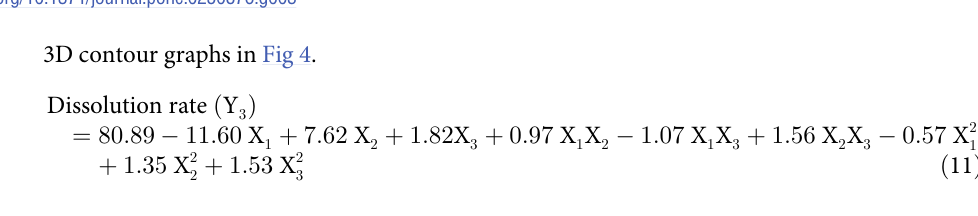
Fig 3. Drug release profiles of the microspheres prepared with (A) 50 mg of ethyl cellulose, (B) with 100 mg of ethyl cellulose, (C) with 150 mg of ethyl cellulose, and (D) of the all formulations.